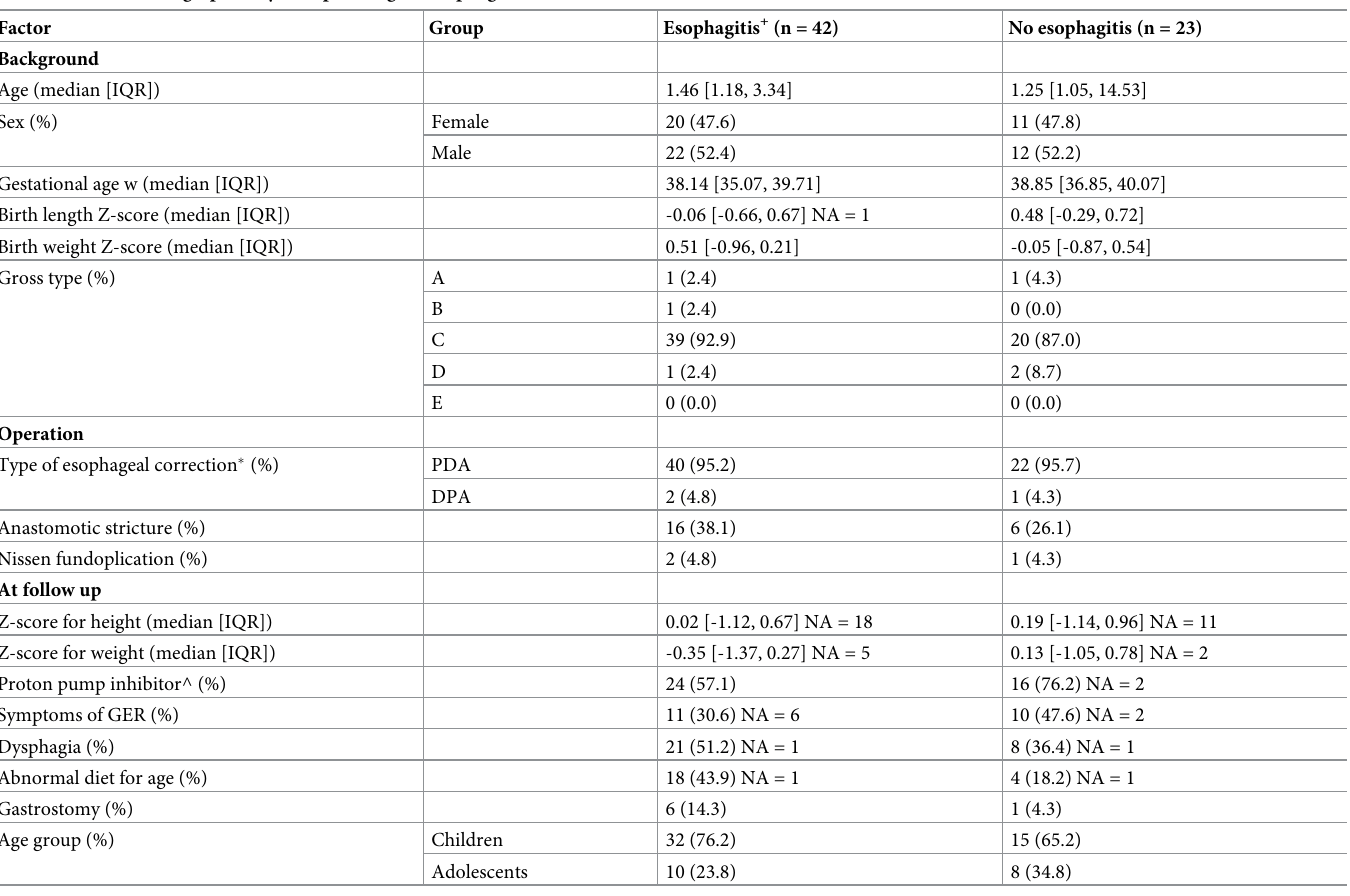
Table 3. Patient demographics by histopathological